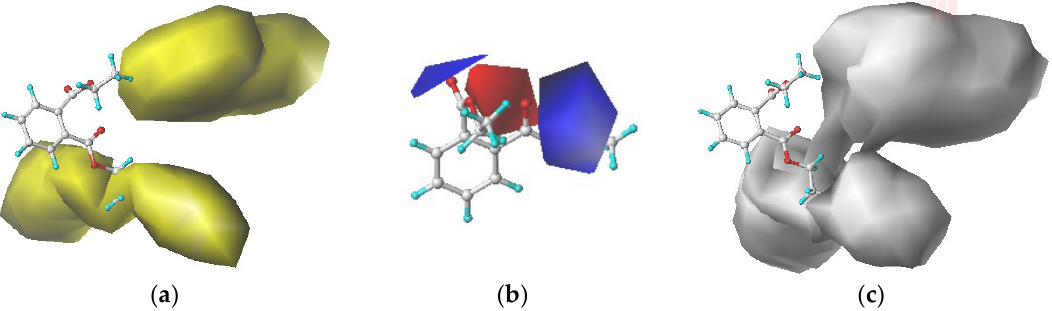
Figure 3. The contour maps from the CoMSIA model of DEP, ( a ) steric field, ( b ) electrostatic field and ( c ) hydrophobic field.